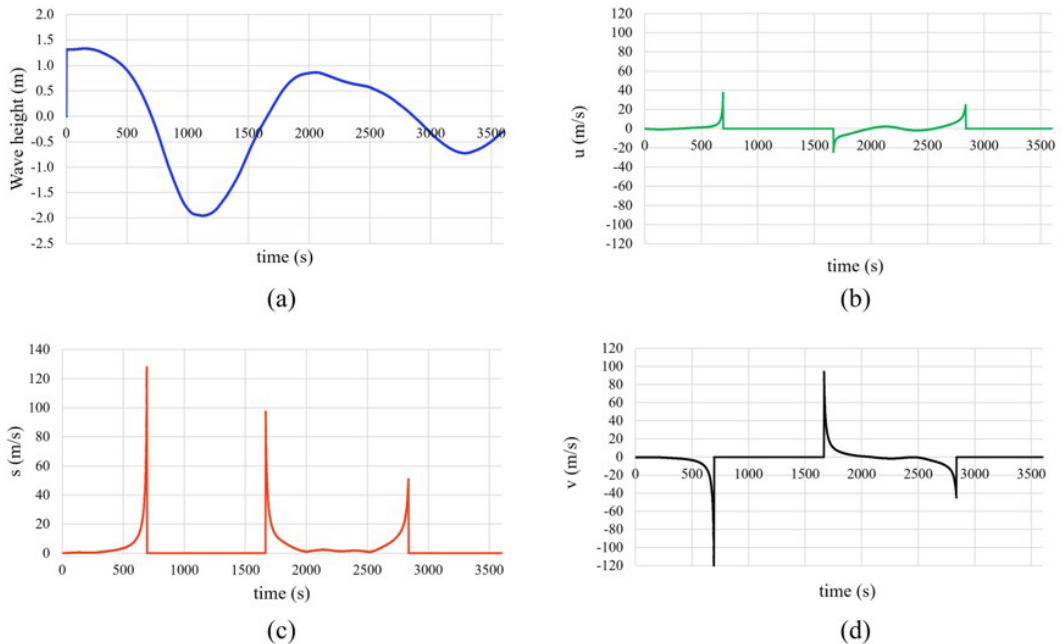
Figure 26. For the gauge nearest to the coast (gauge 5): (a) free sea surface elevation, (b) horizontal velocity u , (c) wave speed s and (d) vertical velocity v .